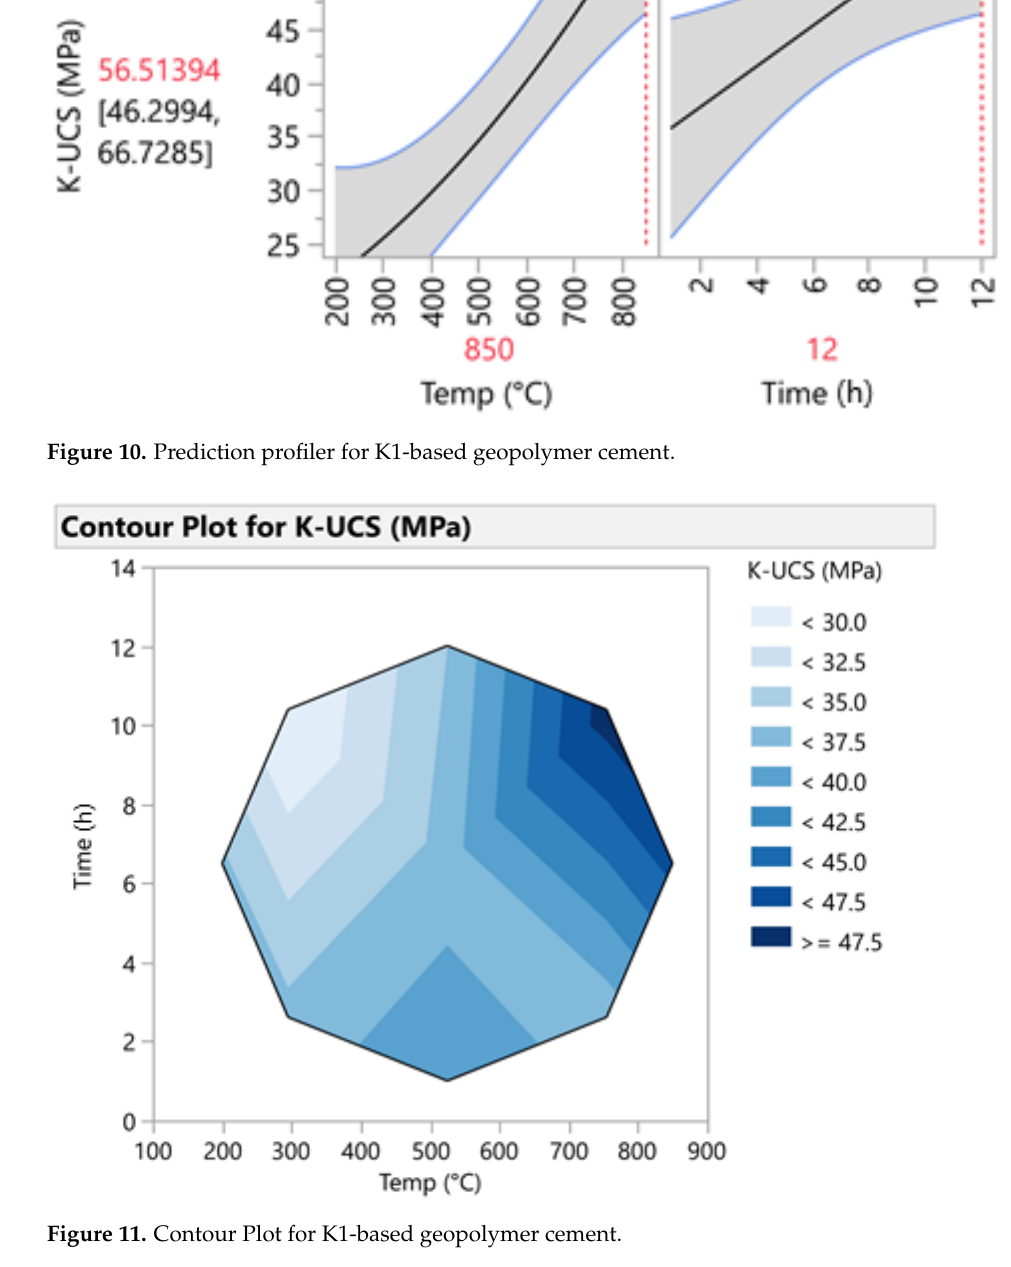
Figure 11. Contour Plot for K1-based geopolymer cement.